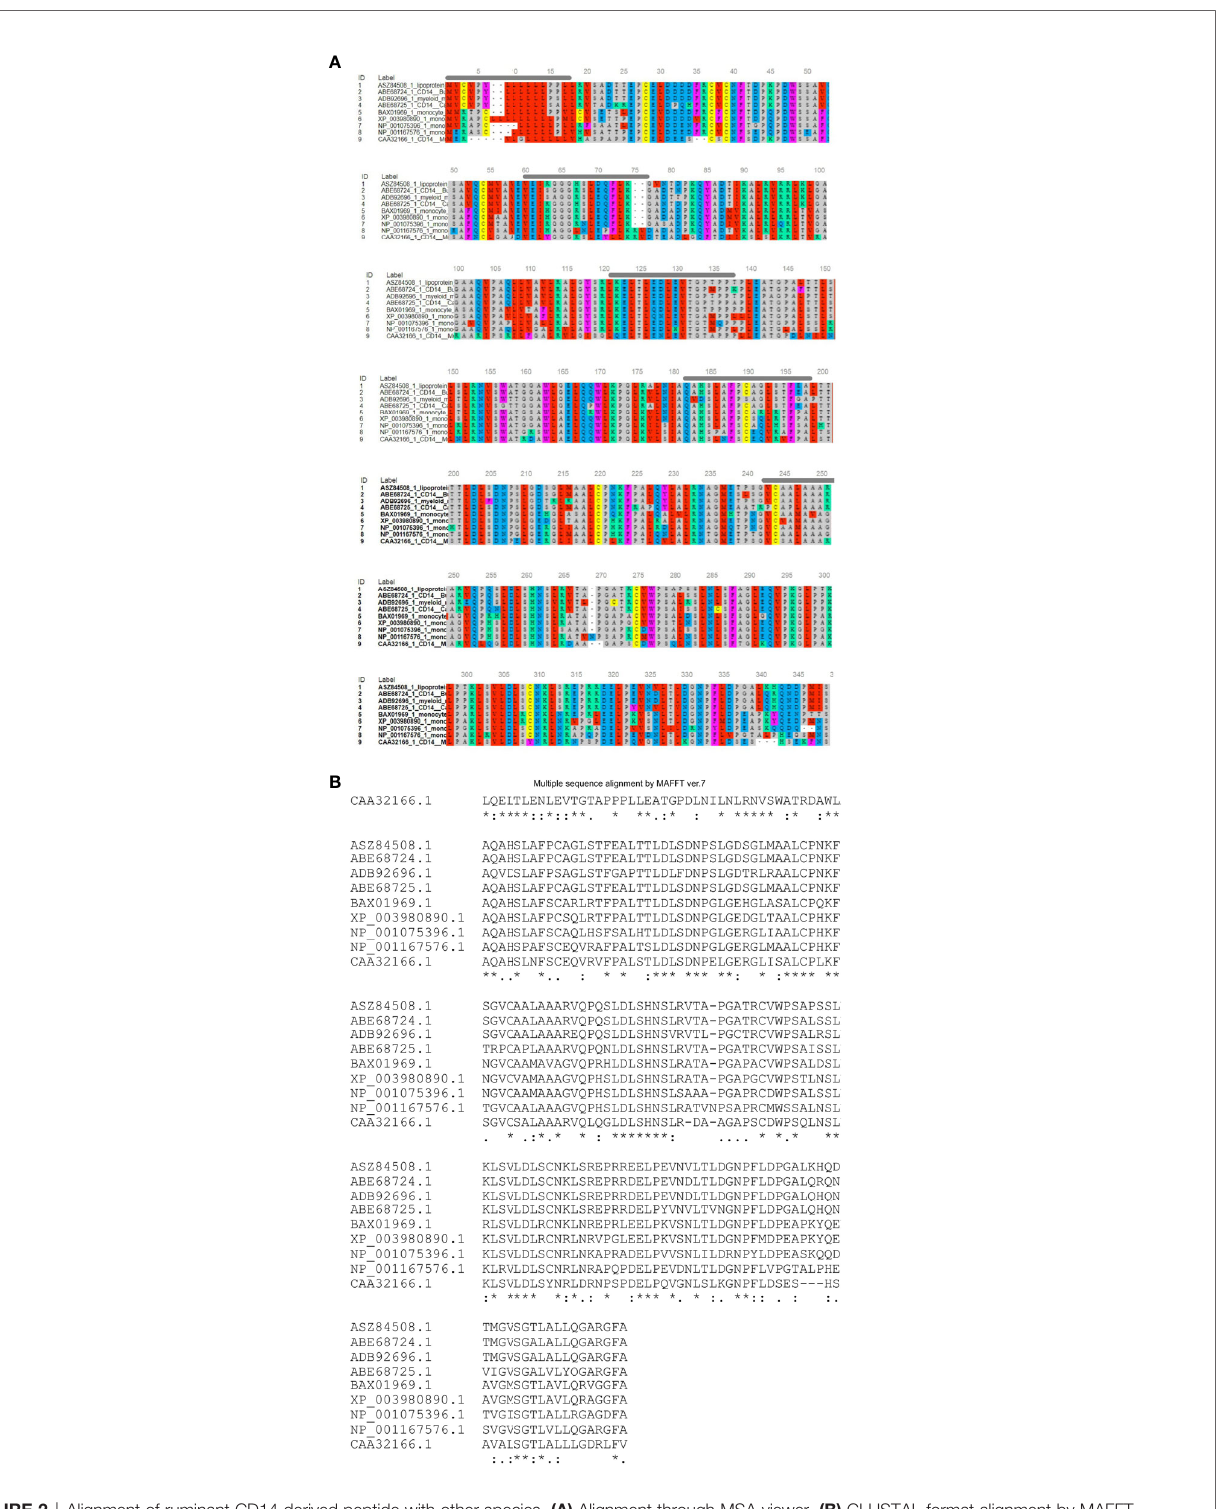
FIGURE 2 | Alignment of ruminant CD14 derived peptide with other species. (A) Alignment through MSA viewer. (B) CLUSTAL format alignment by MAFFT. 1: Sheep (Ovis aries), 2: CB cattle (Bos taurus x Bos indicus), 3: Buffalo (Bubalus bubalis), 4: Goat (Capra hircus), 5: Human (Homo sapiens), 6: Mice (Mus musculus), 7: Dog (Canis lupus familiaris), 8: Cat (Felis catus), 9: Horse (Equus caballus). Green line, Signal peptide; Blue line, LPS binding site; Yellow line, LPS signaling site; Red line, Leucine zipper; Black overline, Leucine rich repeat; Red line, Leucine zipper; Pink line, Domain linker prediction site. * means consensus for single amino acid and it is conserved across the species. ** means two successive amino acids for CD14 correspond to consensus sequence and these amino acid are conserved across the species. Similarly *** corresponds to three amino acids. **** corresponds to four amino acids and so